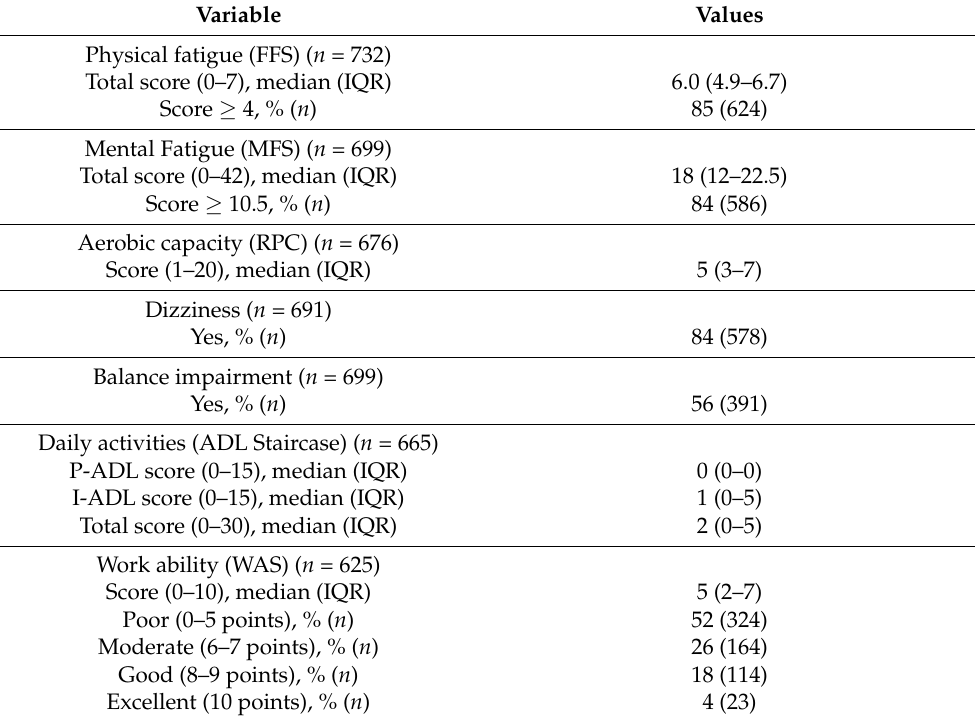
Table 2. Perceived consequences of post-COVID-19.